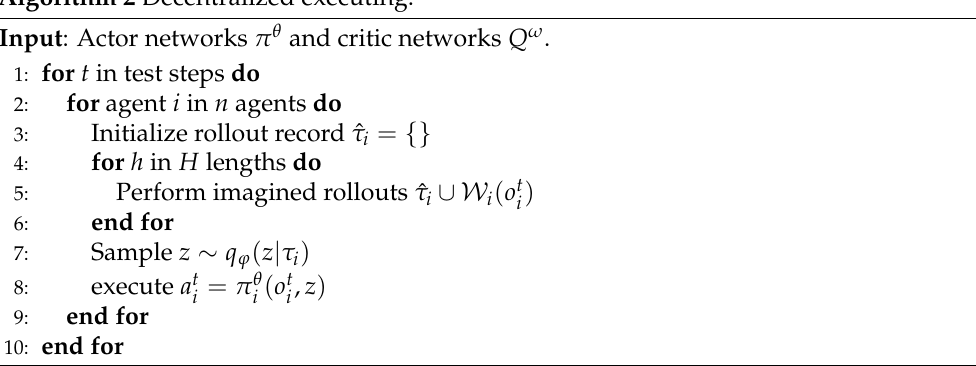
Algorithm 2 Decentralized